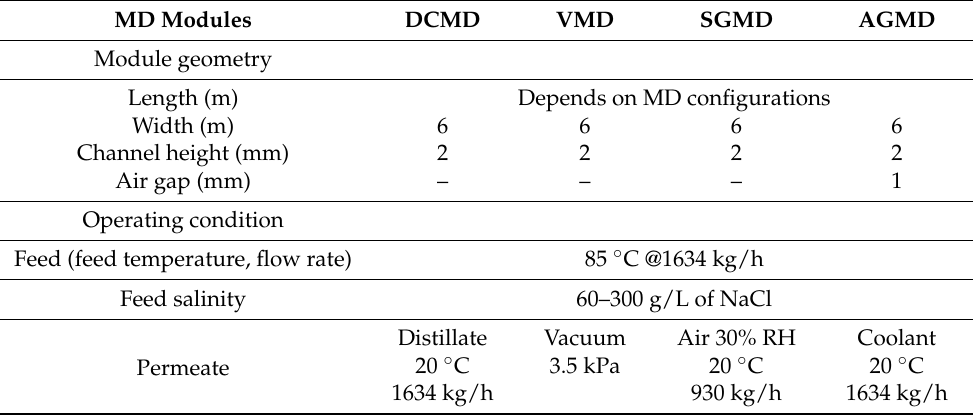
Table 6. Geometry of the modules and operating of MD desalination